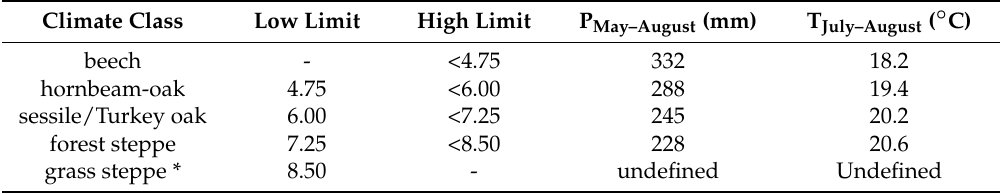
Table 1. Forest Aridity Index (FAI) limits of climate classes and the corresponding precipitation sum of the main growing period (P May–Augst ) and temperature mean of the critical months (T July–August ). The latter are averages for Hungary